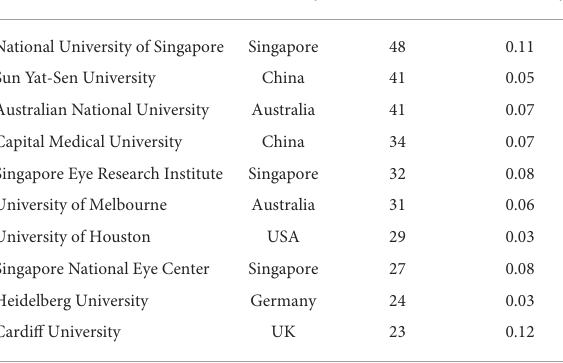
TABLE 2 Top 10 institutions with the most publications from 2006 to